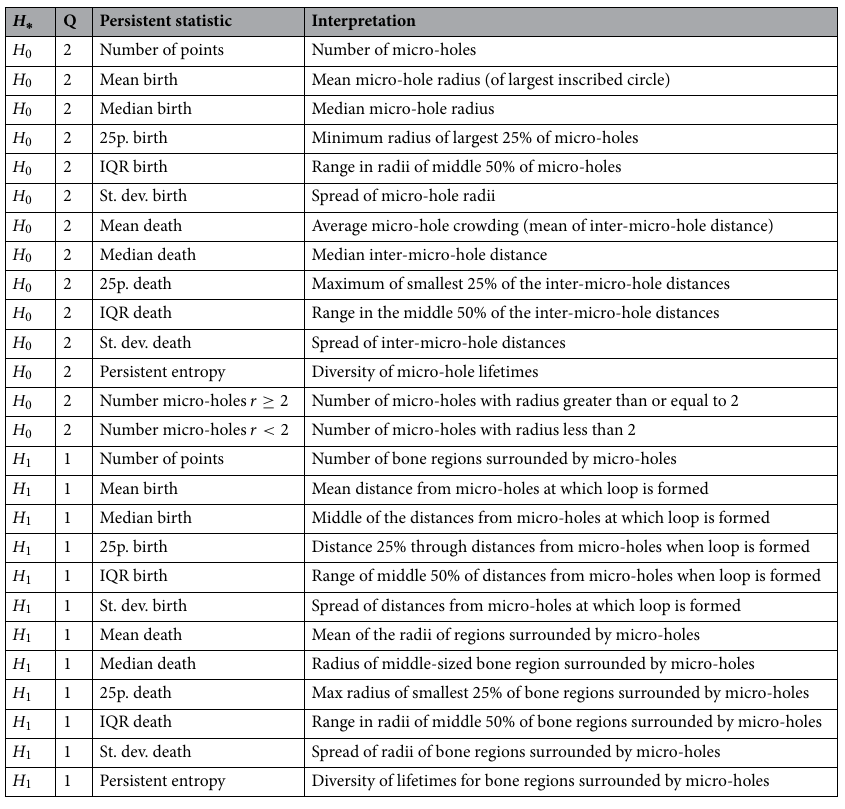
Table 1. Interpretation of persistence statistics. An advantage of using persistent homology with a SEDT filtration is its interpretability. Here we list the persistent statistics that we use and their morphological interpretation. We use ‘Q.’ for quadrant, ‘p.’ for percentile, ‘st. dev.’ for the standard deviation, IQR for the interquartile range, and micro-hole radius or size refers to the radius of the largest inscribed (open) circle. The inter-micro-hole distance is half the distance from one micro-hole to the next nearest